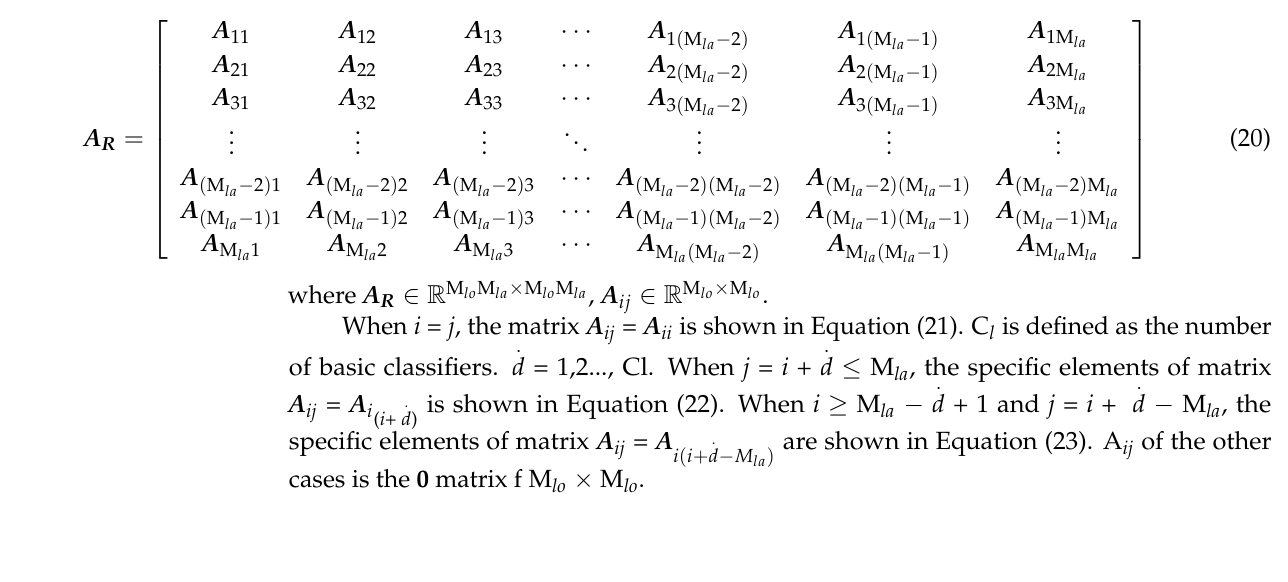
the 0 matrix f M lo × M lo .